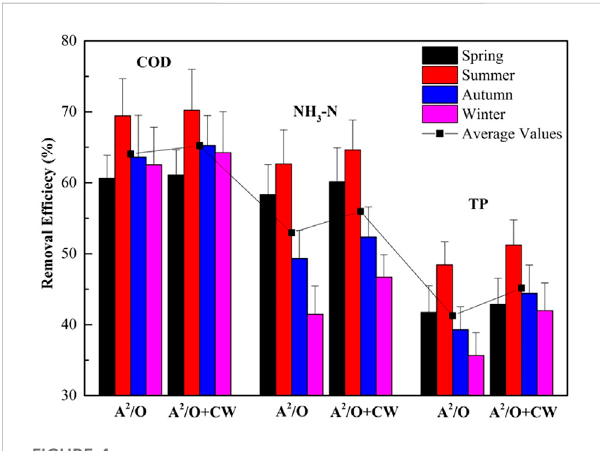
FIGURE 5 Adsorption isotherms (A,C) and kinetics curves (B,D) of phosphorus and ammonia nitrogen for four materials.